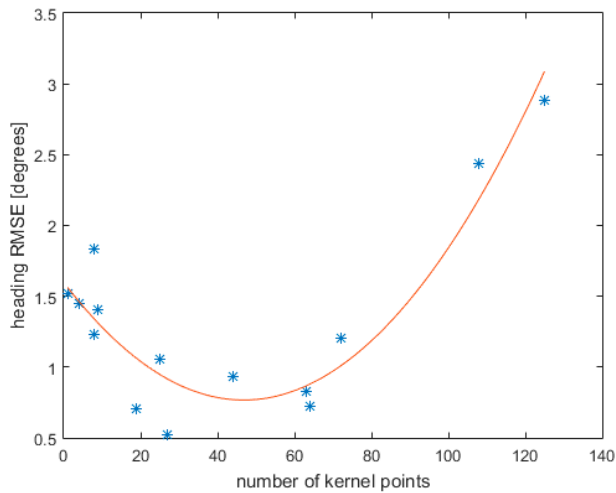
Figure 6. Heading angle RMSE between two different acquisitions as a function of the number of kernel points used in the TPS model. * represent the values directly obtained and the curve is a best fit parabola obtained by a least-squares method.